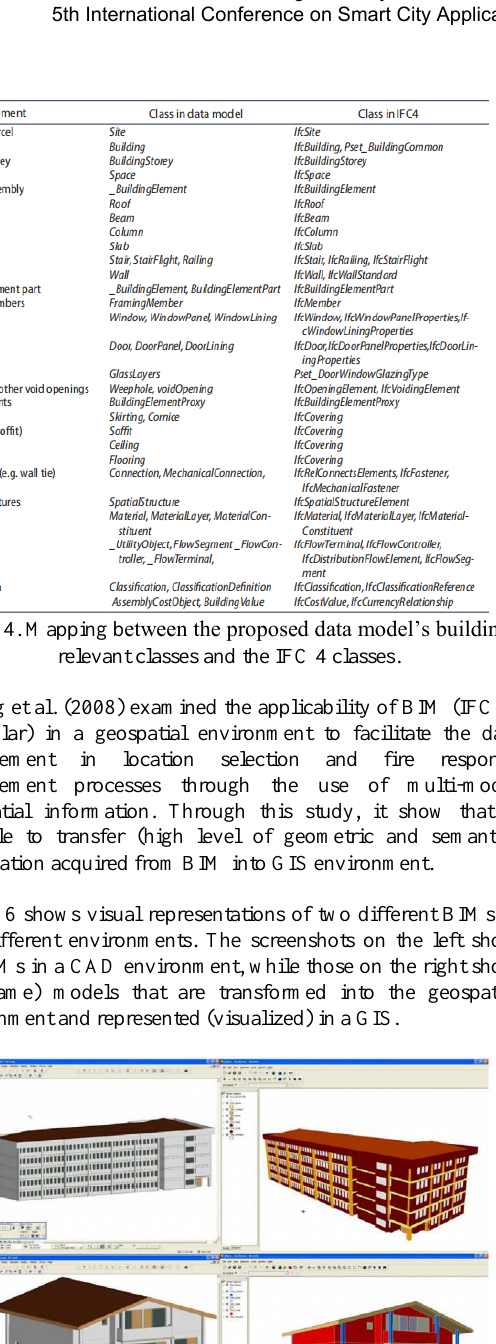
Figure 7. BIM Model in Autodesk